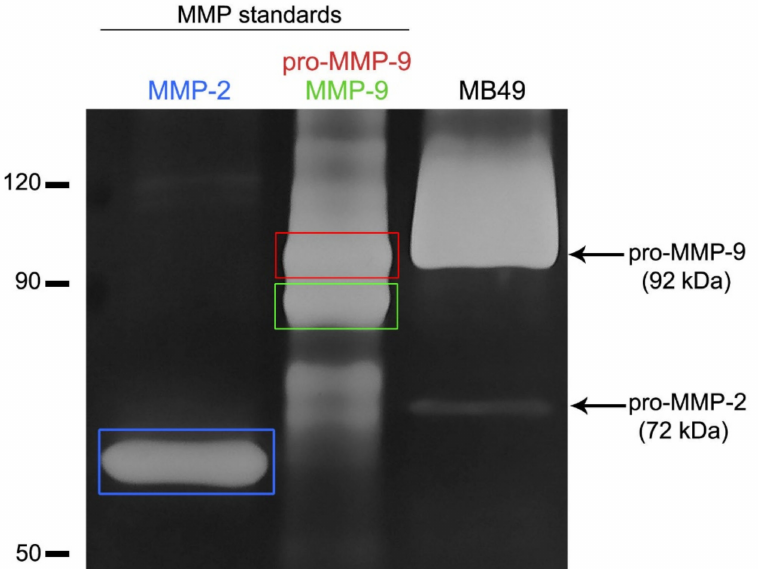
Figure 4. Detection of matrix metalloproteinases (MMP) in the conditioned medium of MB49 cancer cells by gelatin zymography. Gelatinolytic activity was visualized as white bands on dark background. Lanes 1 and 2 indicate recombinant MMP-2 (active form) and MMP-9 (inactive and active form) standard proteins. The detected bands in the conditioned medium of MB49 cancer cells (line